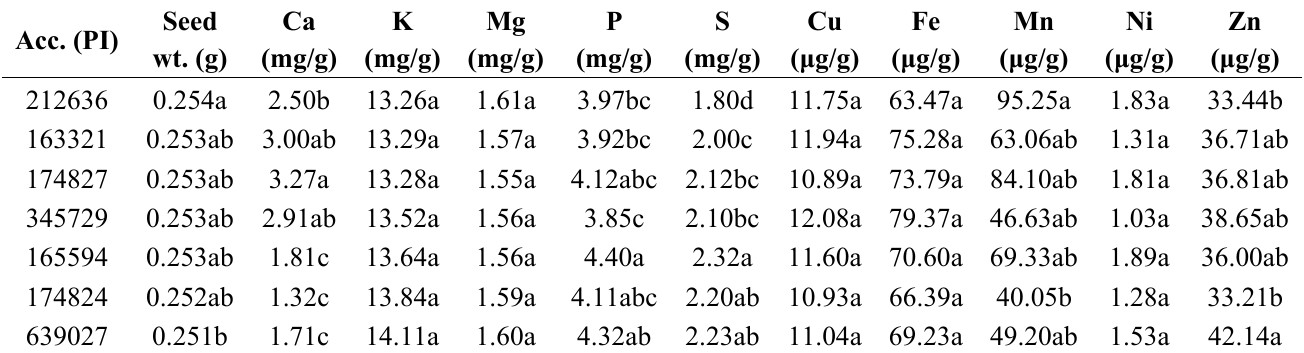
Table 6. Mean mineral composition (macro-minerals are expressed as mg/g; micro-minerals are expressed as μ g/g dry weight) among seven horse gram accessions grown in 2009 and